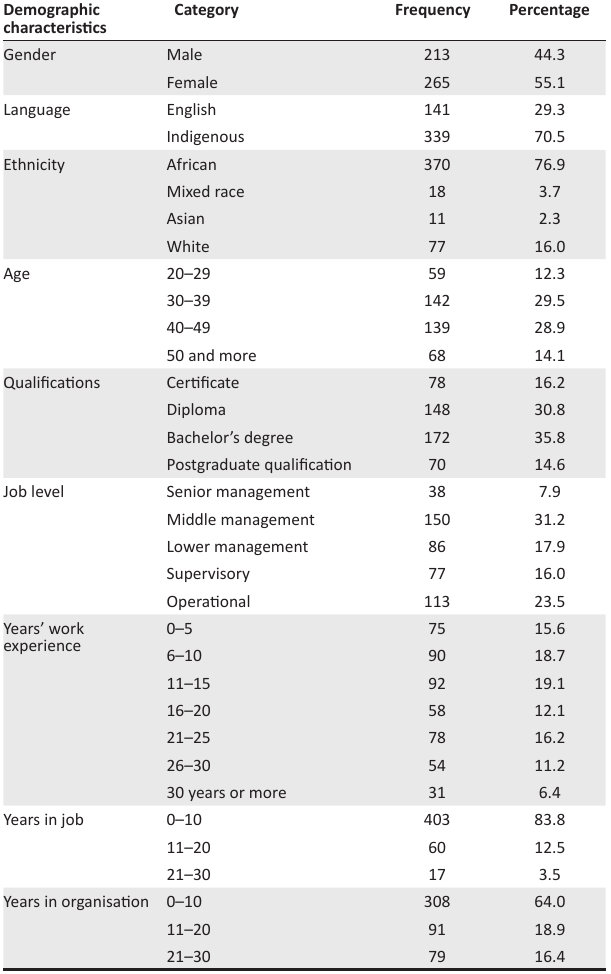
TABLE 1: Demographic characteristics of the respondents. Demographic